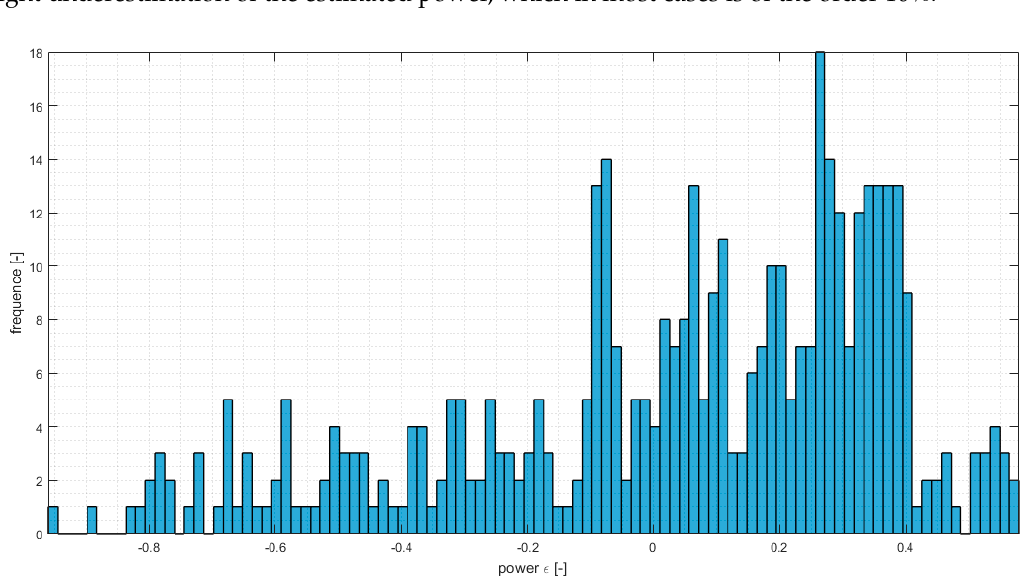
Figure 11. Probabilistic distribution of the error for the validation period.